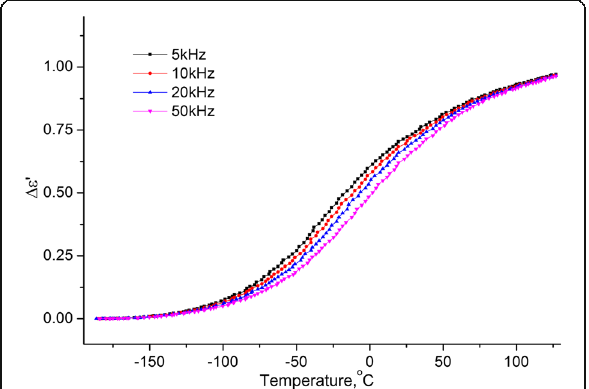
Fig. 8 Temperature dependence of the change of increment of real part of the complex dielectric permittivity. Temperature dependence of the change of increment of real part ( Δ ε ′ = ε ′ ( T ) − ε ∞ , ε ∞ ¼ ε ′